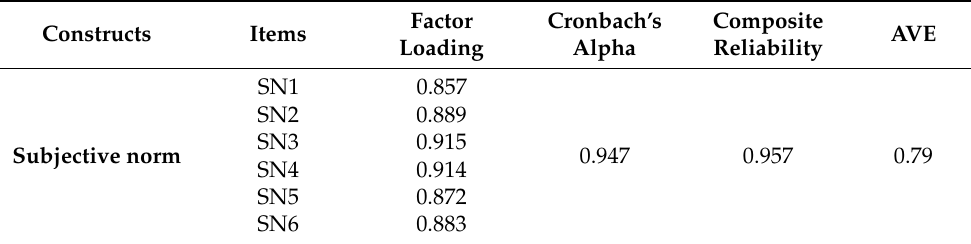
Table 1. Factor Loading, Cronbach alpha, Composite Reliability &